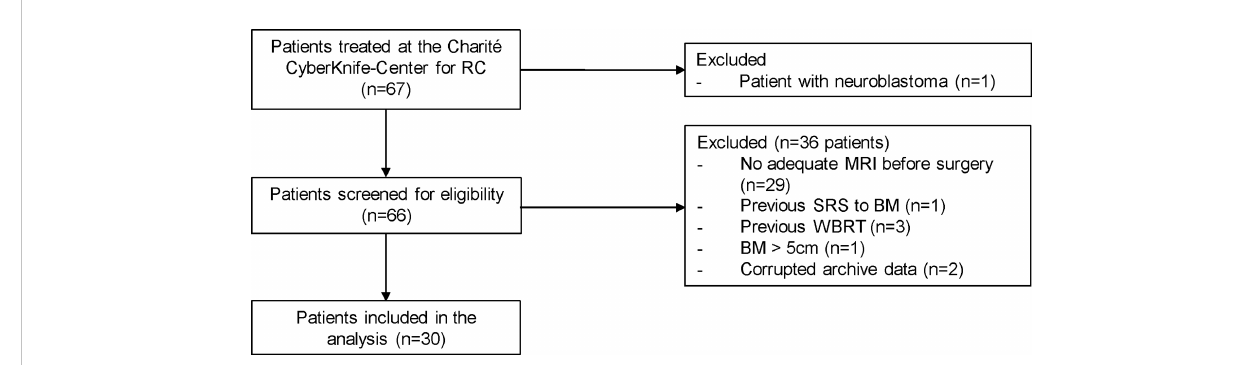
FIGURE 1 Patients with surgically resected brain metastases who underwent postoperative stereotactic radiosurgery to the resection cavity in our department were included. One pediatric patient with neuroblastoma was excluded from the cohort. Additional exclusion criteria included: no adequate intracranial MRI before surgery, previous SRS at the index lesion or WBRT as well as a diameter of the preoperative lesion greater than 5 cm. Two patients had to be additionally excluded because their data could not be extracted from the Accuray archive. RC, resection cavity; BM, brain metastasis; SRS, stereotactic